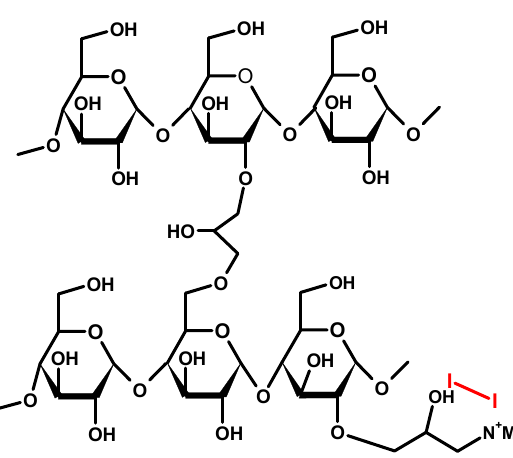
Figure 4. Structure of cationic starch iodophores [22,23].